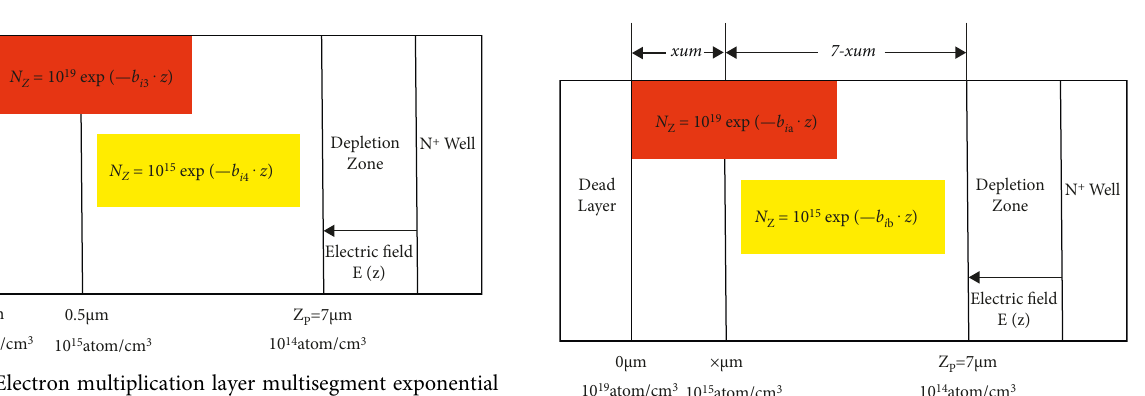
Figure 8: Charge collection efficiency in the 5 × 5 pixel region.